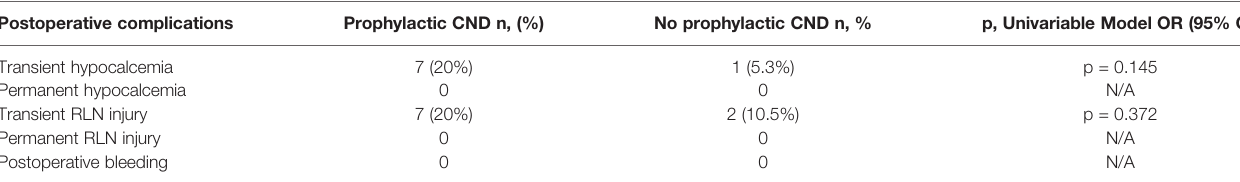
TABLE 5 | Postoperative complications for patients with cN0 pediatric thyroid carcinoma. Postoperative complications Prophylactic CND n, (%) No prophylactic CND n, % Transient